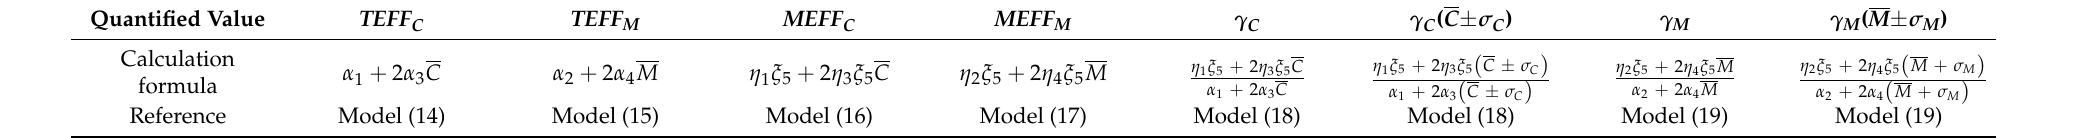
Table A2. The calculation process for the quantified